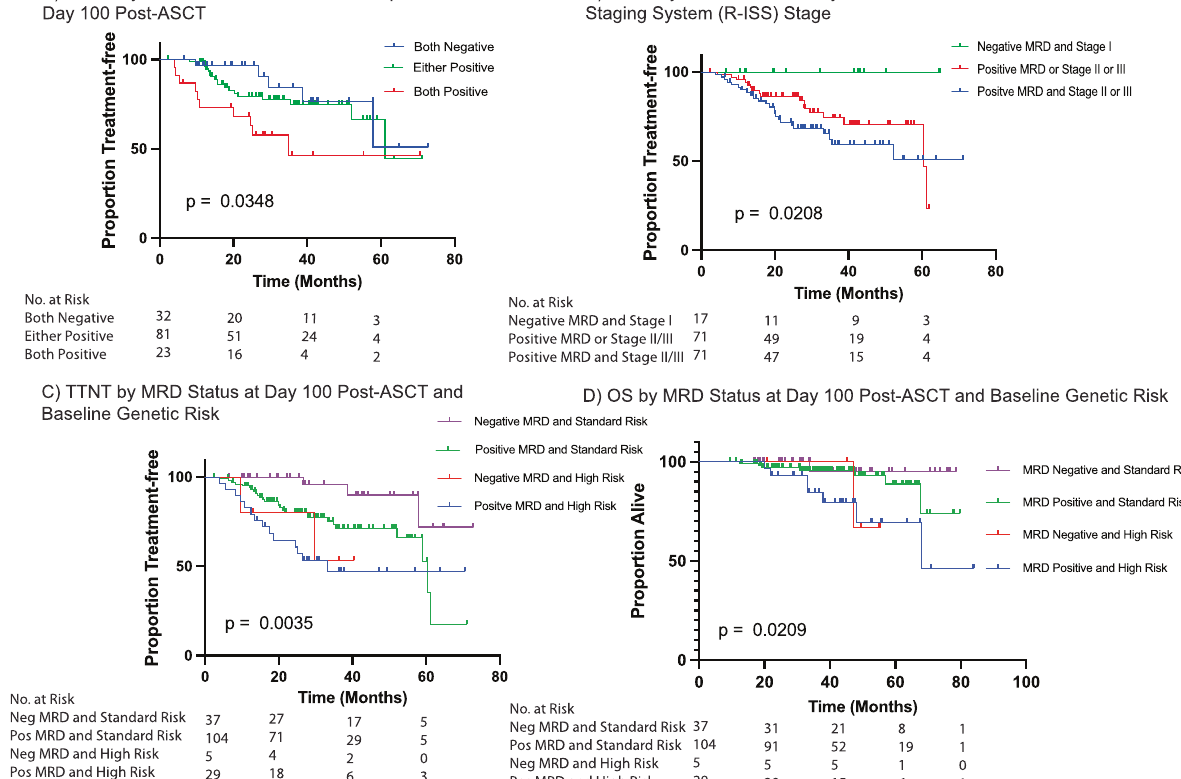
Fig. 3 Kaplan Meier curves for time to next treatment (TTNT) and Overall Survival (OS) According to MRD Status in Combination with Other Disease Parameters. A According to MRD status and PET-CT Interpretation at day 100. Patients with both MRD and PET-CT negative did not reach median TTNT. Patients who had either MRD positive or PET-CT positive had a median TTNT of 61 months; this group was mostly compromised of patients with positive MRD and negative PET-CT (79; 97%) while only a small number of patients (2; 3%) were PET-CT positive/MRD-negative. Patients who had both assessment positive had a median TTNT of 34.9 months. B Based on MRD status at day 100, and R-ISS stage at time of diagnosis. Patients with MRD negativity and R-ISS Stage I did not reach a median TTNT. Patients who had both positive MRD and Stage II or Stage III did not reach a median TTNTeither. Patients with either a positive MRD or Stage II or Stage III disease had a median TTNT of 60.5 months. C According to MRD status at day 100 and genetic risk at time of diagnosis. Patients with negative MRD and standard risk genetics, and patients with negative MRD and high-risk cytogenetics did not reach median TTNT. Those with positive MRD and standard cytogenetics had a median TTNT of 60.5 months, while those with positive MRD and high-risk cytogenetics had a median TTNT of 33.1 months. D OS according to MRD assessment at day 100 and genetic risk at time of diagnosis. Only patients with positive MRD and high- risk genetics reached a median OS of 68.1 months. The other three subgroups did not reach median OS.